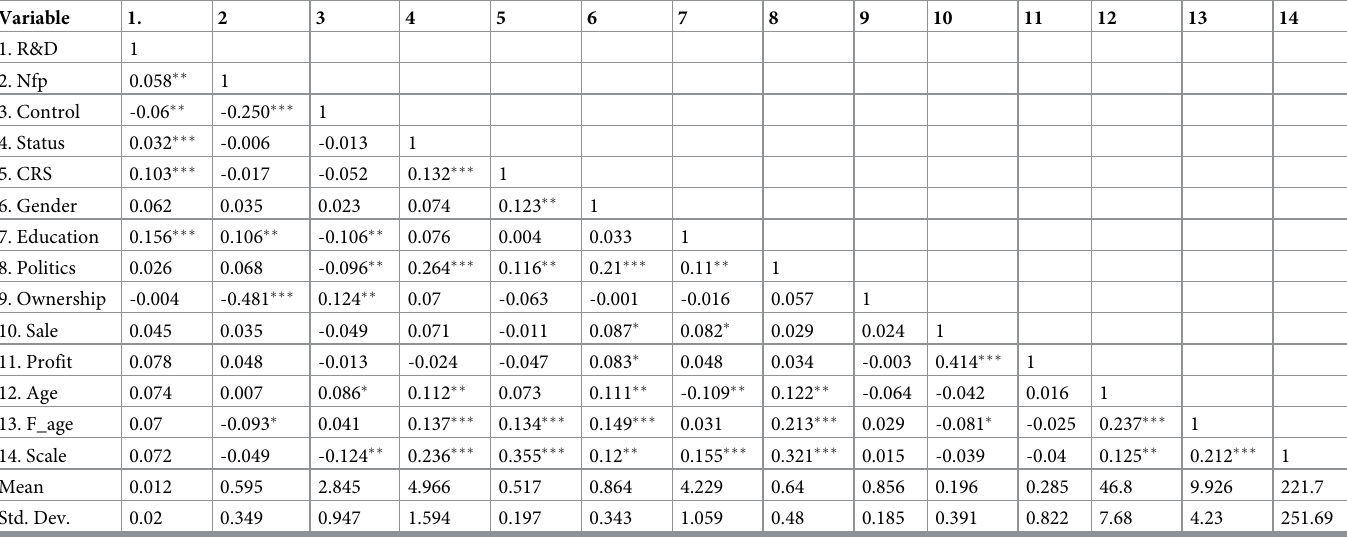
Table 1. Descriptive statistics and